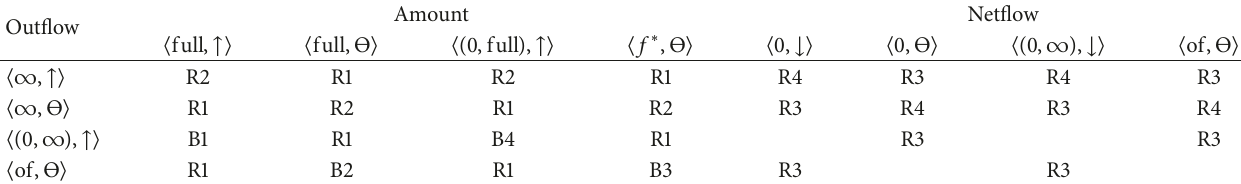
Table 6: Filtering behaviors using 𝑀 + (amount, outflow) and Add (netflow, outflow, inflow). Amount Netflow Outflow